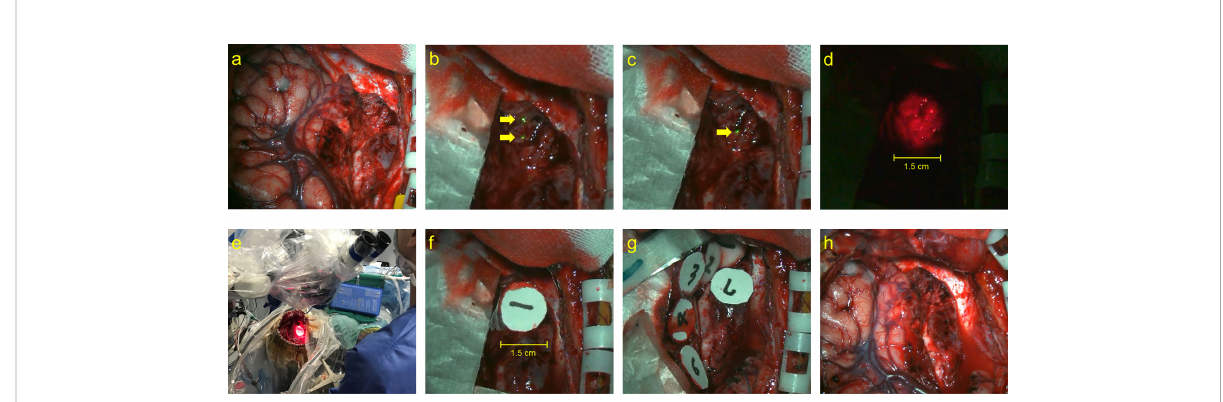
FIGURE 1 The actual performance of PD laser delivery during PDT. (A) The surgical view of tumor resected cavity, (B) the two identical green laser beams projected by a laser irradiation unit from a different site (yellow arrows), (C) the depth at which the two laser beams intersected in the resection cavity (yellow arrow), (D) the irradiation fi elds of approximately 1.5 cm in diameter, (E) the macroscopical surgical view of PDT procedure, (F, G) the sterile numbered sheets with the same diameter of 1.5 cm were placed to enable recognition of the irradiated area, and (H) the fi nal view of the surgical cavity after